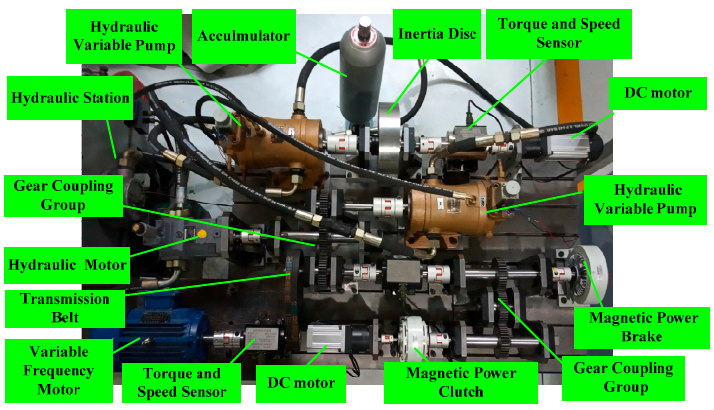
Figure 2. Sketch diagram of the test station. 1. DC motor (1); 2. torque and speed sensor (1); 3. inertia